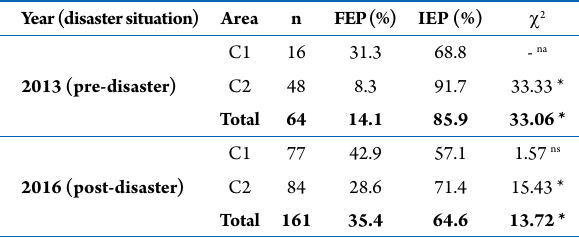
Table 1. Extractive Potential (%) recorded for the mangrove crab ( Ucides cordatus ) in two mangrove areas (C1 and C2), municipality of Cubatão (Brazil), regarding the environmental disaster (2013: pre-disaster; and 2016: post-disaster), that occurred in 2015 at ULTRACARGO (AT). Where: FEP, future extractive potential (juvenile crabs: carapace width < 60mm); and IEP, immediate extractive potential (adult crabs: carapace width ≥ 60mm); χ 2 , chi-square test.